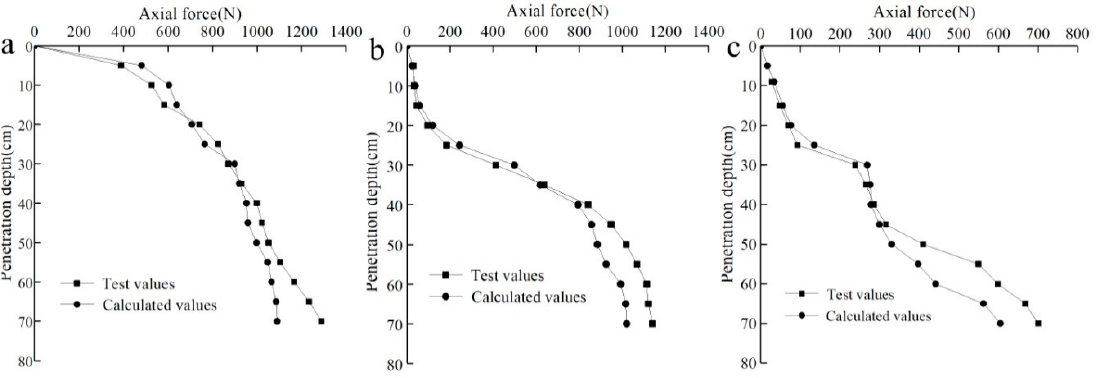
Figure 14. The relationships between the axial force and the penetration depth: ( a ) a-a section, ( b ) b-b section, ( c ) c-c section.